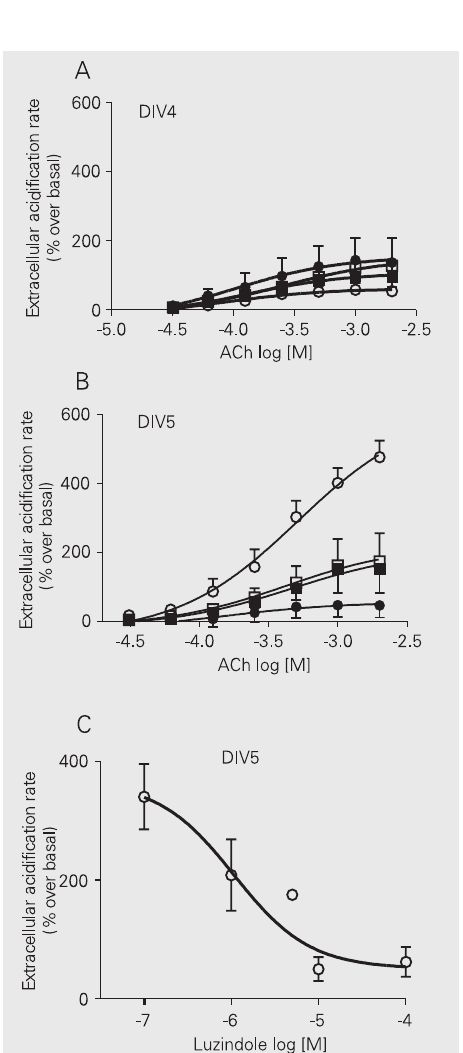
Figure 5. [ 125 I]- α -bungarotoxin (BTX) binding saturation curves for retinal cultures. Nonspecific binding was determined with 1 mM nicotine. Four-day (DIV4, squares) and 5-day (DIV5, circles) in vitro cultures were in- cubated for 60 min at 37 º C. Data are reported as means ± SEM for 3 independent experiments.